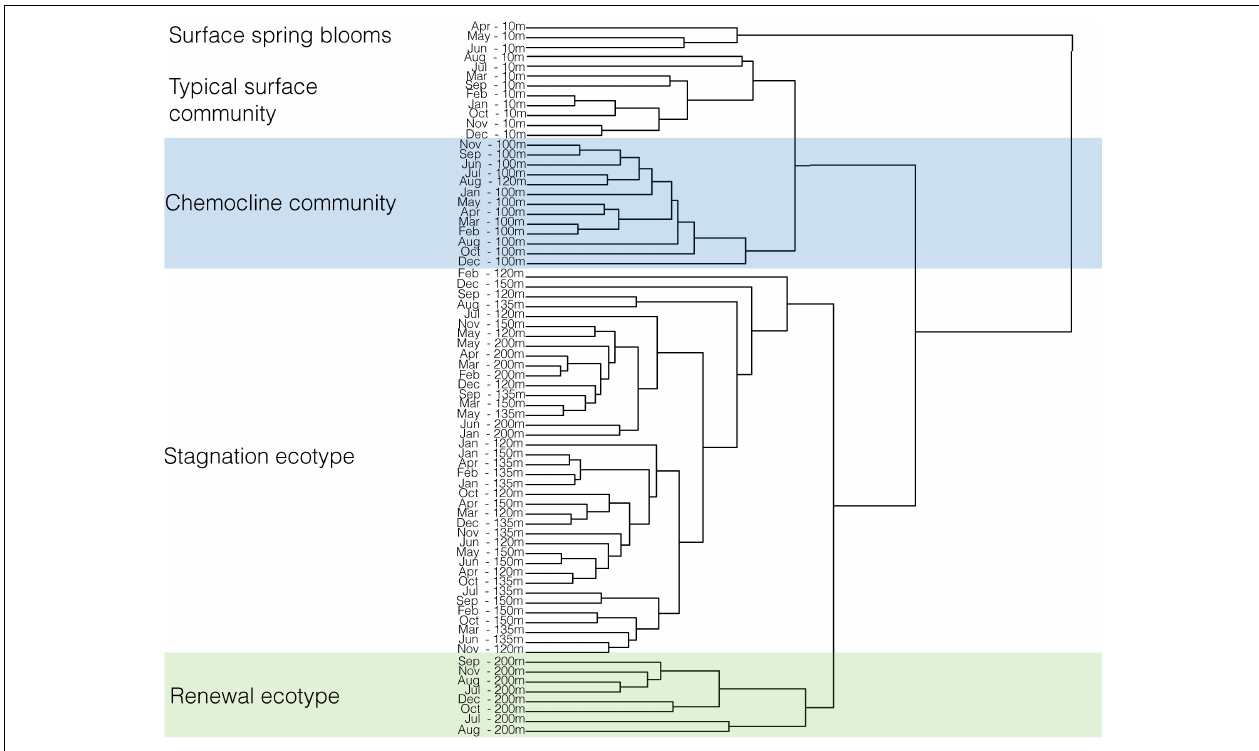
FIGURE 8 | Clustering of the microbial community composition of SI in 2015 for 6 depths (10, 100, 120, 135, 150, and 200 m) and 12 months. Dissimilarities between samples is shown by the height of the fusion of the dendrogram: the higher the fusion, the more dissimilar samples are between each other. Clustering of samples was performed in R with the Euclidean method.